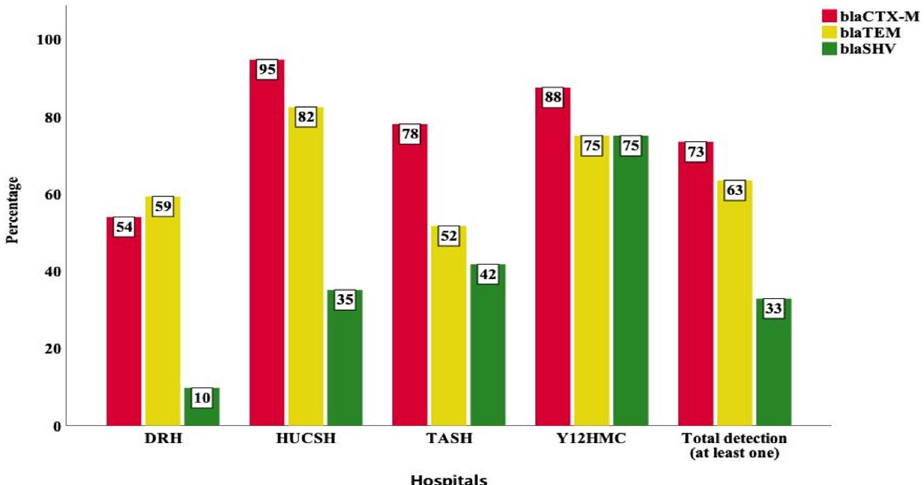
Figure 1. Frequency of bla CTX-M , bla TEM and bla SHV families detected at least once from